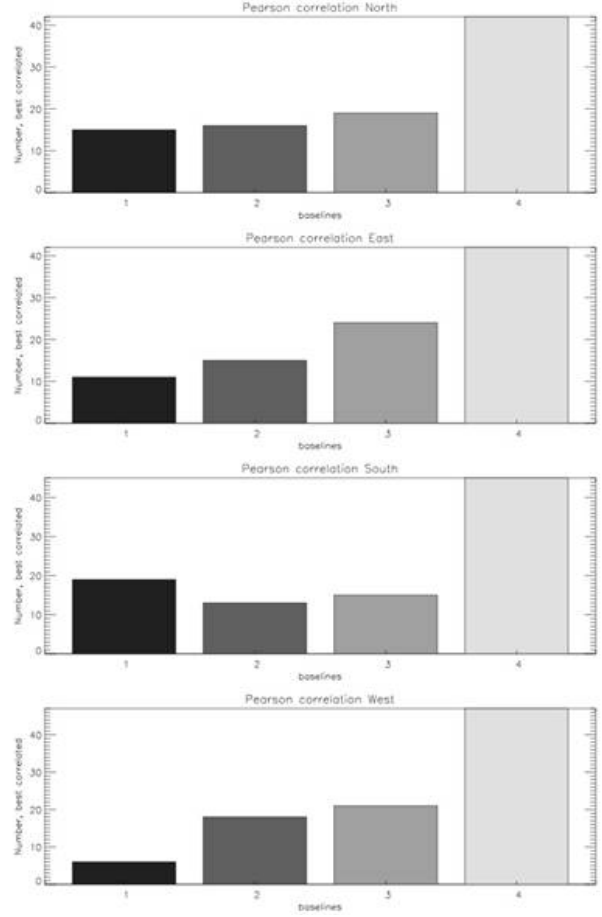
Fig. 10. Pearson cross-correlation of SCANDI and FPI LOS winds where 4 different baselines are used to determine the SCANDI LOS winds (see